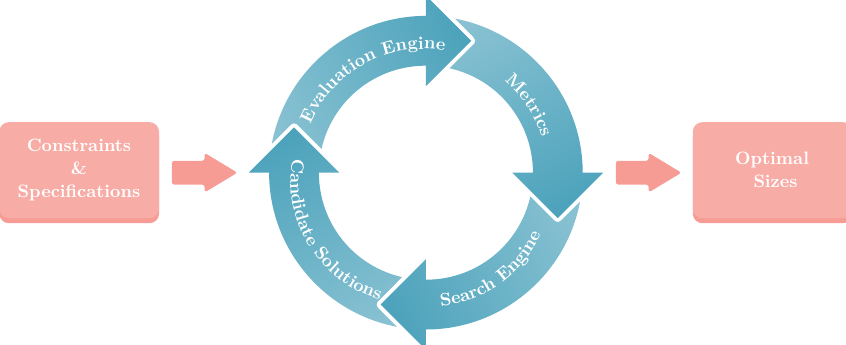
Figure 1. Optimization-based flow of analog circuit